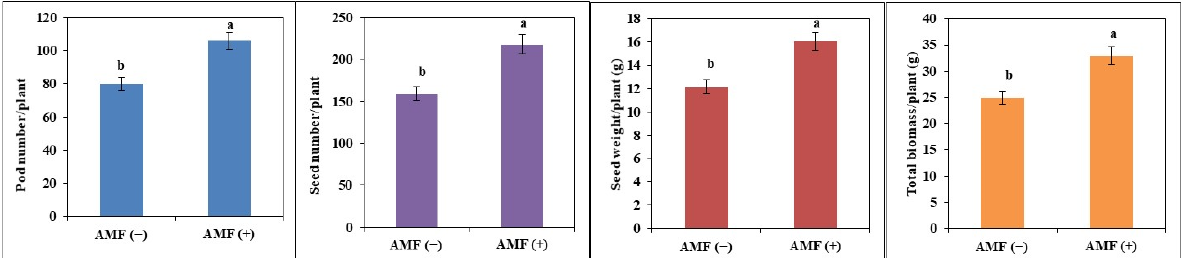
Figure 7. Pod number, seed number, seed weight, and total biomass of non ‐ inoculated AMF ( − ) and inoculated plants AMF (+) of soybean. The vertical bar indicates ± SE for the mean. The means for each main treatment followed by the different letters are significantly different ( p ≤ 0.05).